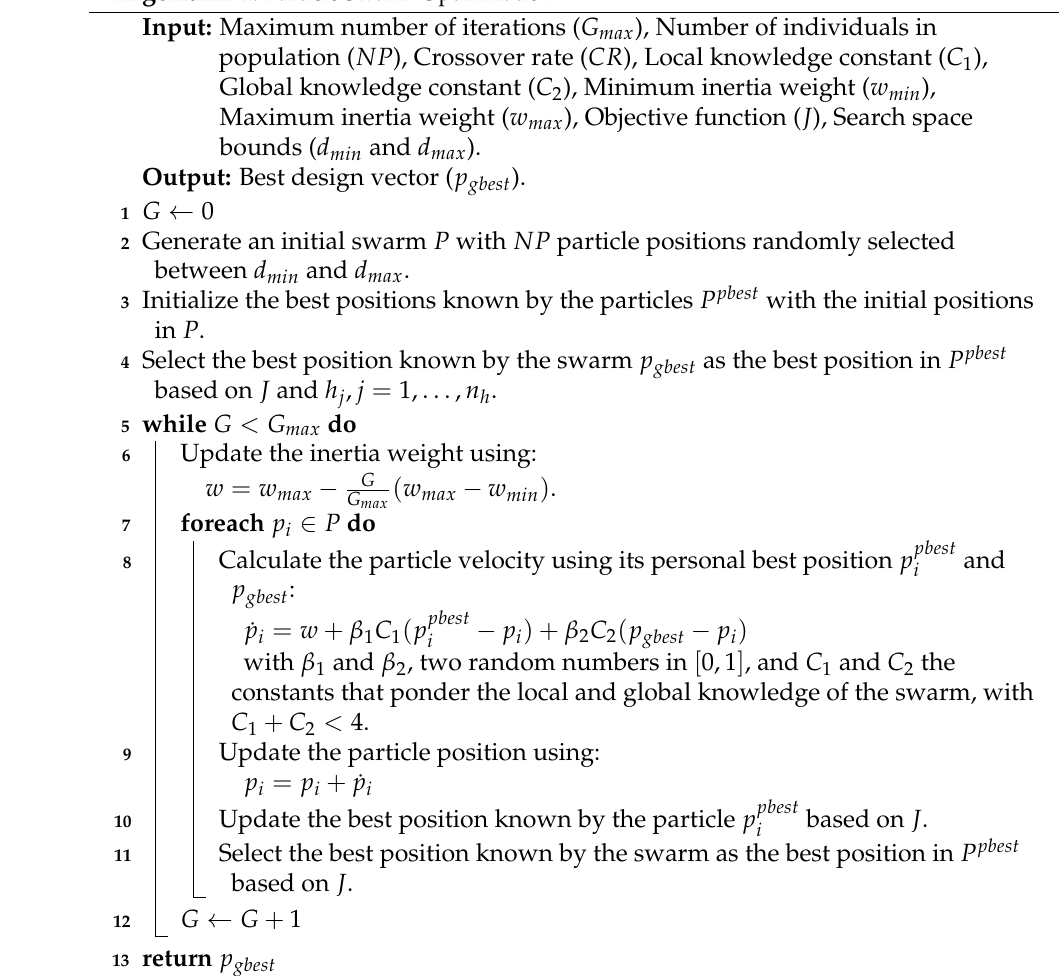
Algorithm 4: Particle Swarm